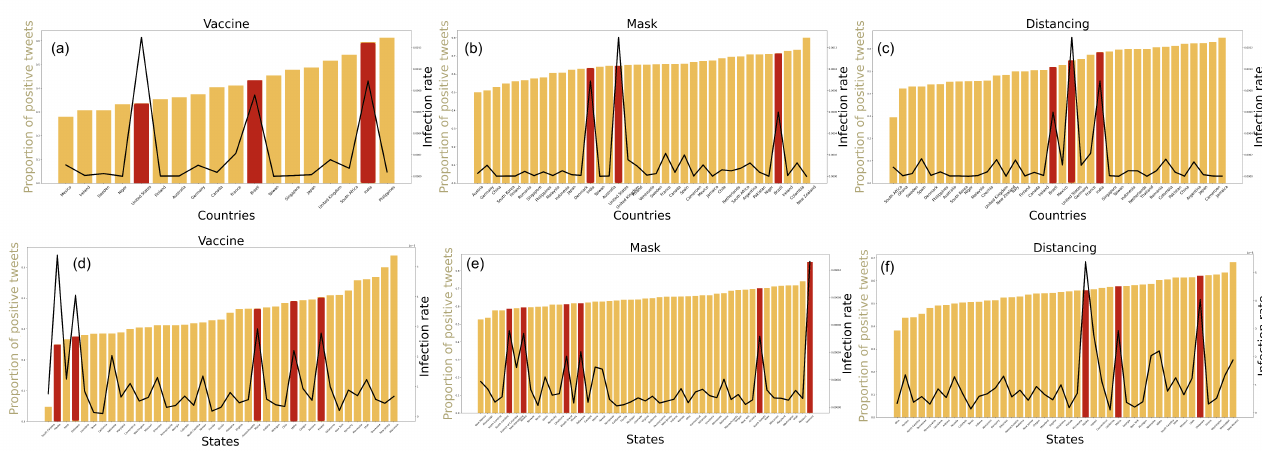
Figure 5. Fraction of positive tweets on vaccine, mask and social distancing from the ( a – c ) countries and ( d – f ) US states and their total infection numbers (between the tweet period) normalized by their population